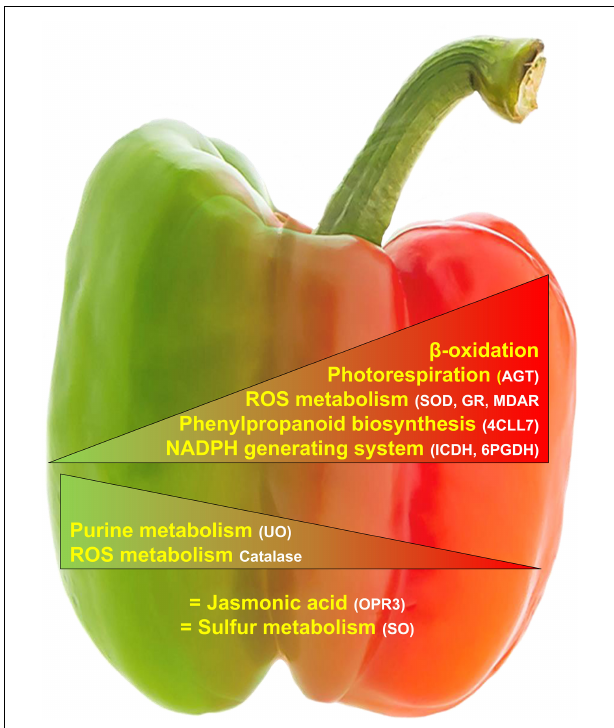
FIGURE 5 | Working model of the main peroxisomal processes where the detected proteins are either positive/negatively modulated or not affected during pepper fruit